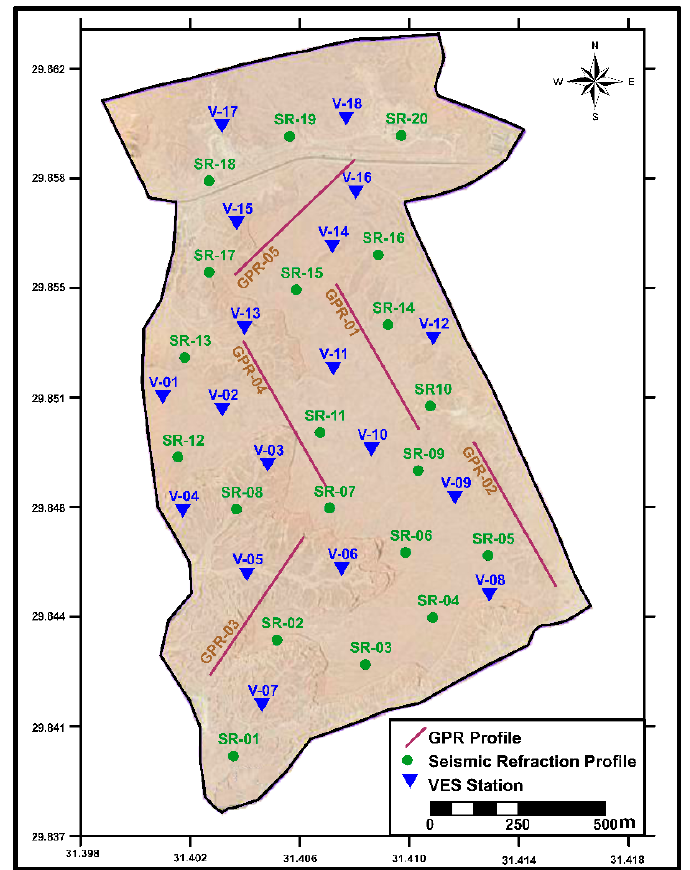
Figure 6. Location map of the conducted geophysical survey in the investigated site.